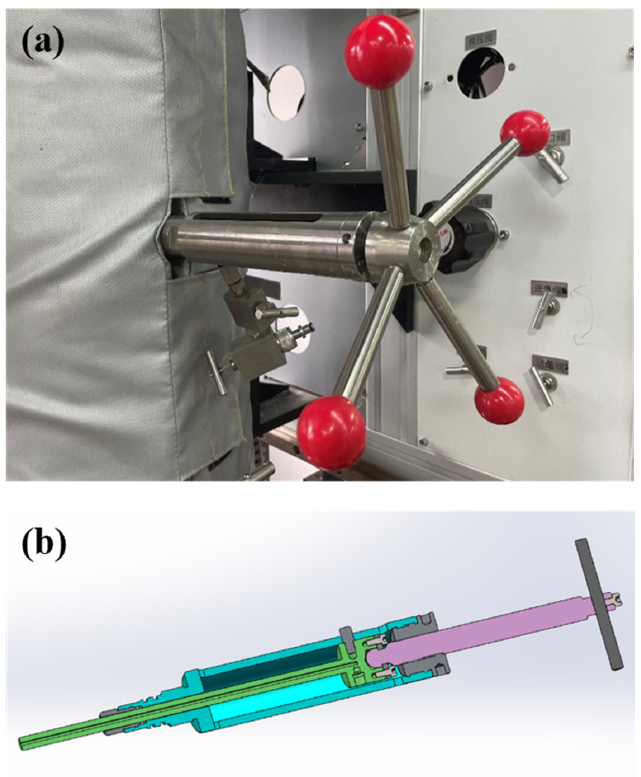
Figure 7. ( a ) Physical drawing and ( b ) three-dimensional section of movable liquid